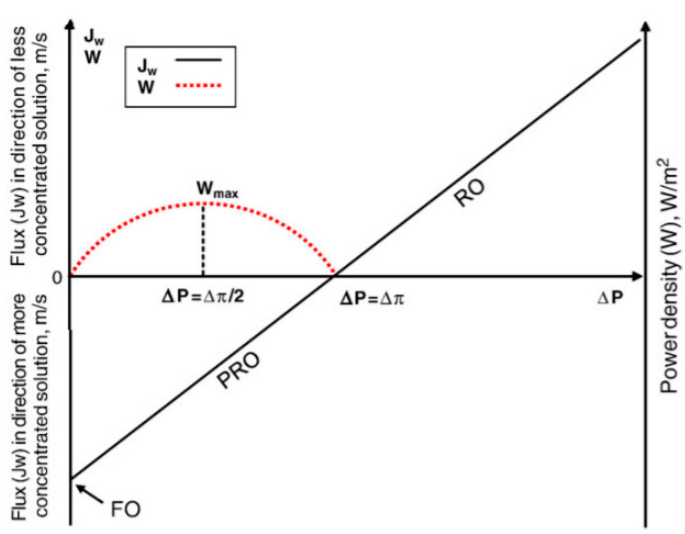
Figure 2. A comparison of FO, PRO, and RO along with the change of external hydraulic pressure. A red-dashed parabola represents the power density of PRO according to external hydraulic pressure [30]. The figure is reproduced from Reference 30] with